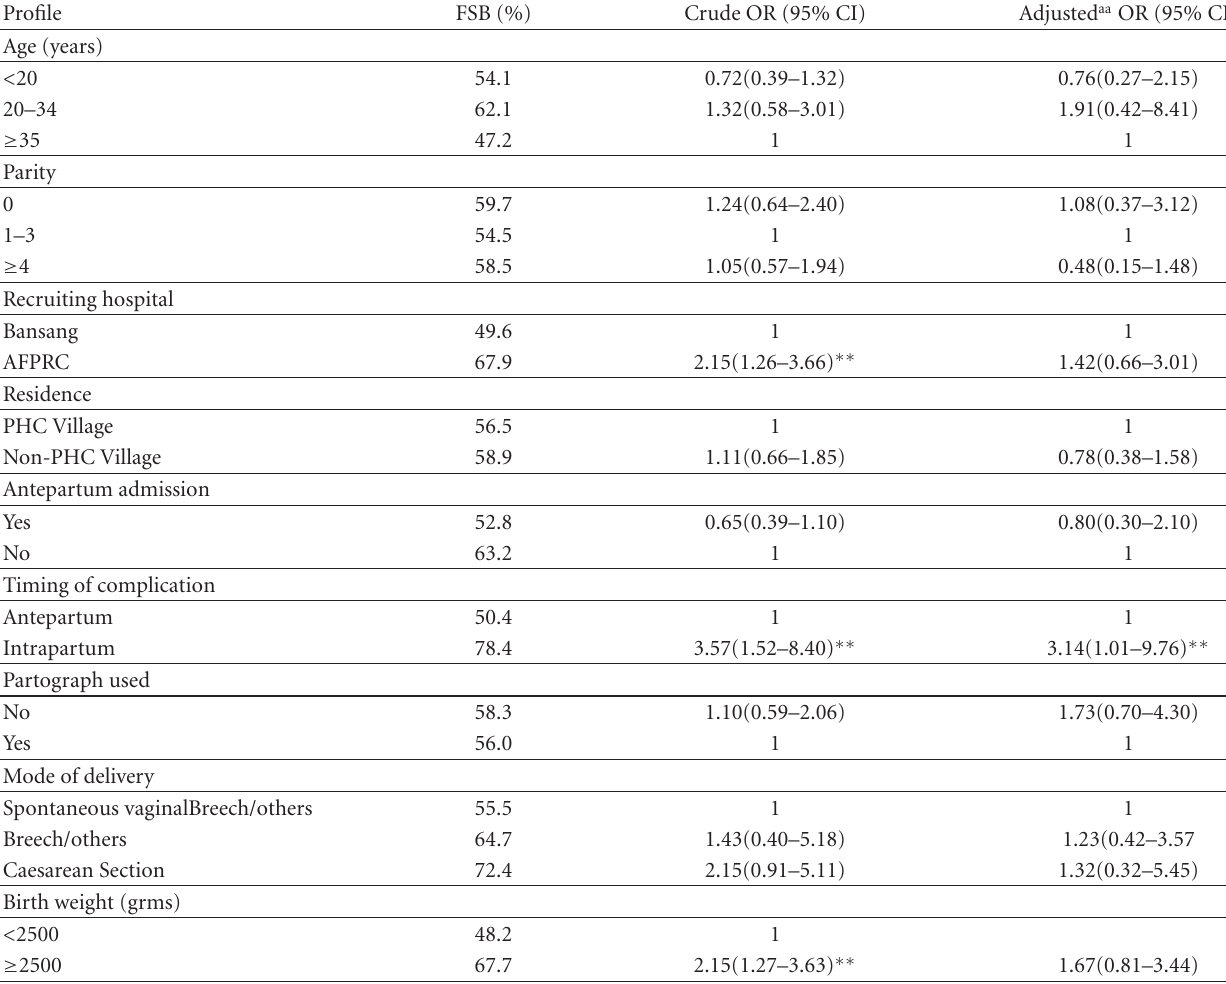
Table 2: Maternal demographic and obstetric factors associated with fresh stillbirth (FSB)